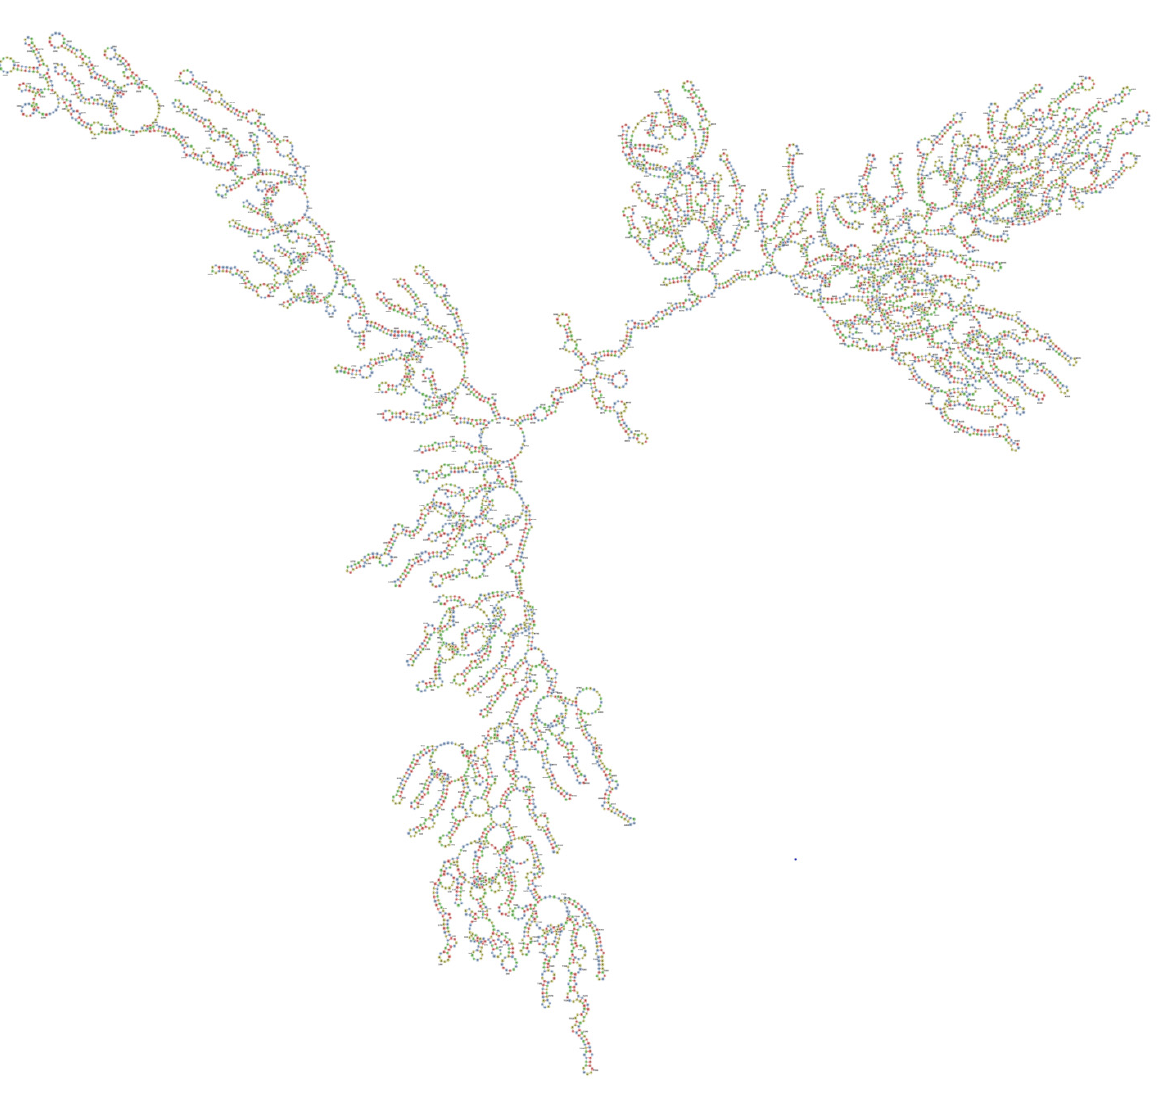
Figure 3. The proposed centroid secondary structure of the MERS-CoV-ORF1ab gene with nucleotide positions was predicted using RNAfold software and downloaded in PNG format. The phosphodiester backbone is shown in orange color and the nucleotides are shown in the sticks and filled rings with elemental coloring; Green, red, yellow and blue. The color of the secondary structure indicates; green: C (canonical helices), red: G (junctions), yellow: A, blue: U hairpin loops. The structure shows all the nucleotides and their bindings with each other and forming stem, hairpin loops, canonical helices, and junctions. Chemically modified nucleotides are unpaired, in A-U or G-C pairs at helix ends, in G-U pairs anywhere, or adjacent to G-U pairs.